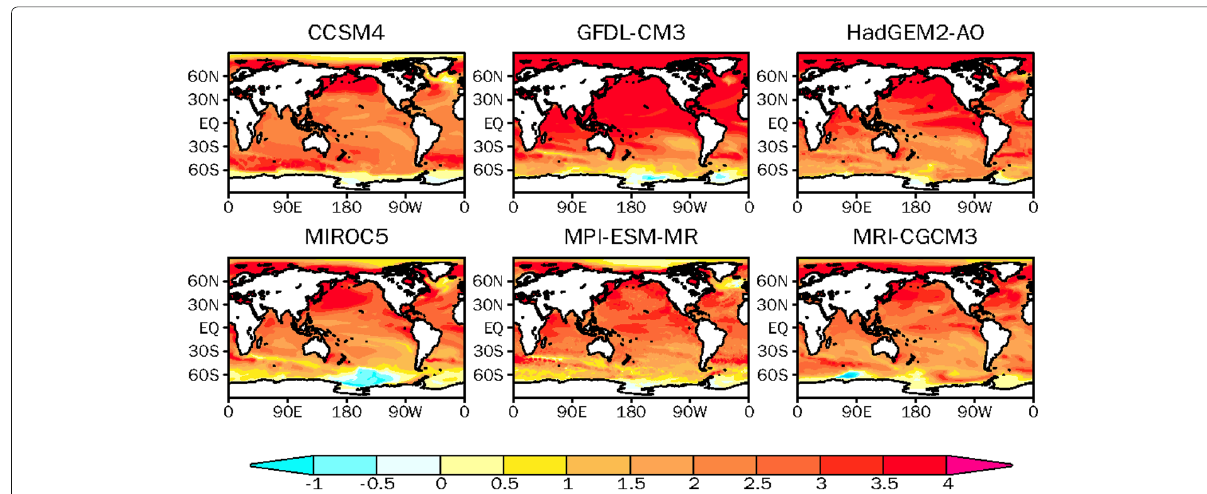
Fig. 2 Geographical distributions of sea surface temperature differences (K) of six CMIP5-participating climate models between two periods from 1991 to 2010 and from 2080 to 2099. The values indicate mean changes in climatological SSTs for January in years from 2080 to 2099 relative to those from 1991 to